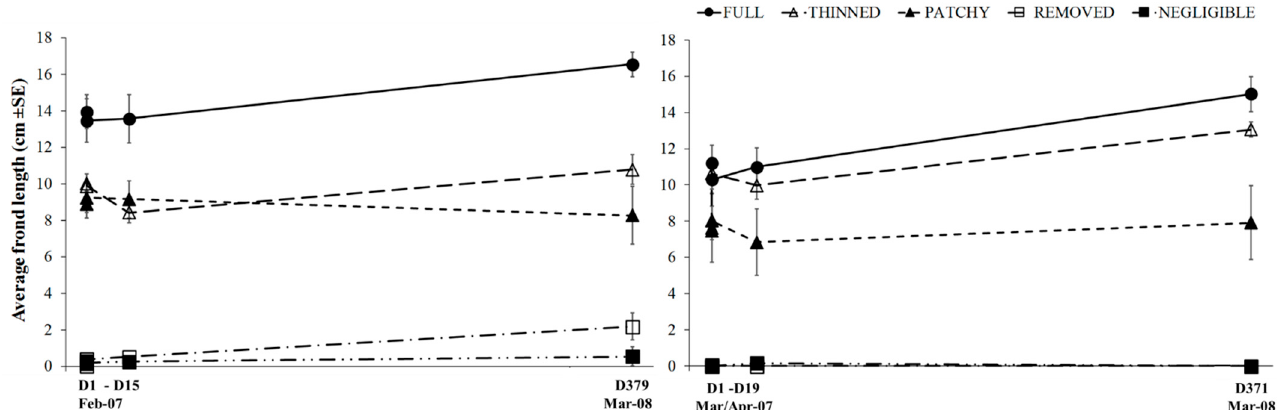
Figure A4. Average sand depth (cm ± se) between treatments and over time at 13th Beach (left hand side) and Bridgewater Bay (right hand side).